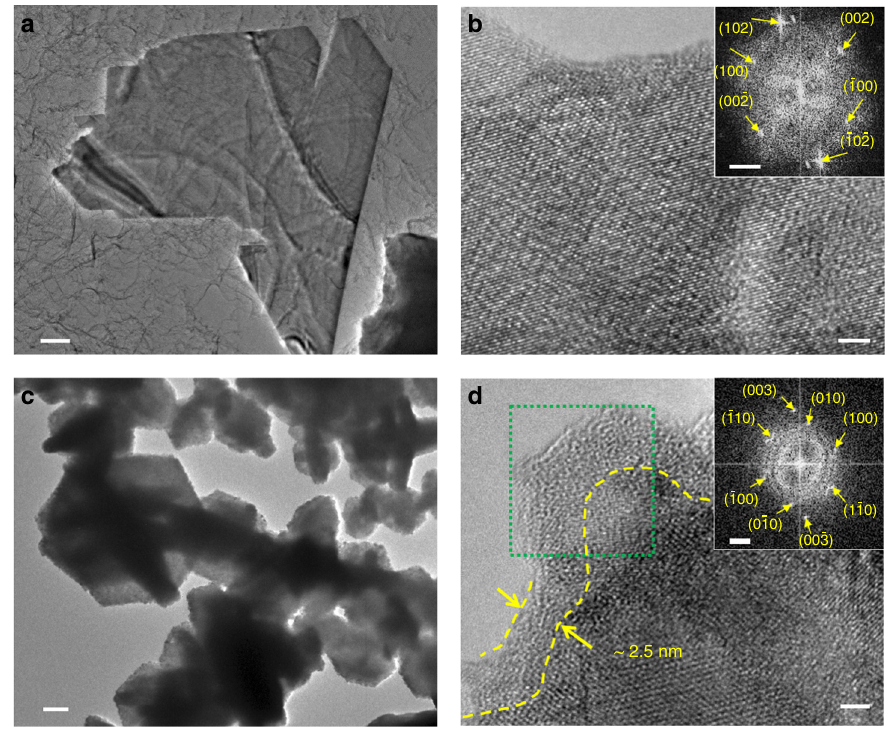
Fig. 2 TEM and HRTEM characterization of VS 2 and VS 2 -TiS 2 . a TEM (scale bar = 200 nm) and b HRTEM image (scale bar = 2 nm, inset shows the corresponding FFT pattern (scale bar = 2 nm − 1 )) of a typical VS 2 fl ake. c TEM (scale bar = 200 nm) and d HRTEM image (scale bar = 2 nm, inset shows the FFT pattern (scale bar = 2 nm − 1 ) of the region within the green box) of a typical VS 2 -TiS 2 fl ake. TEM transmission electron microscopy, HRTEM high- resolution transmission electron microscopy, FFT Fast Fourier pro fi les of the VS 2 and VS 2 -TiS 2 electrodes between 1.5 and 3.5 V (vs. Li/Li + ) at a current density of ~200 mA g − 1 are shown in Fig. 3a. The electrochemical intercalation and removal of Li in VS 2 can be described by the following reaction: